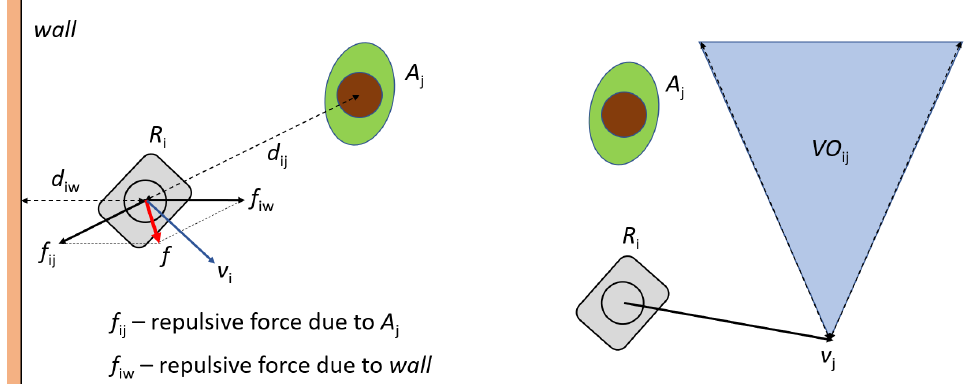
Figure 5. ( Left ) Forces of SFM. The resulting force f in the robot R i is provoked by a static obstacle (the wall, f iw ) and a mobile one A j ( f ij ). ( Right ) The velocity obstacle VO ij for a robot R i induced by a mobile agent A j , with velocity v j